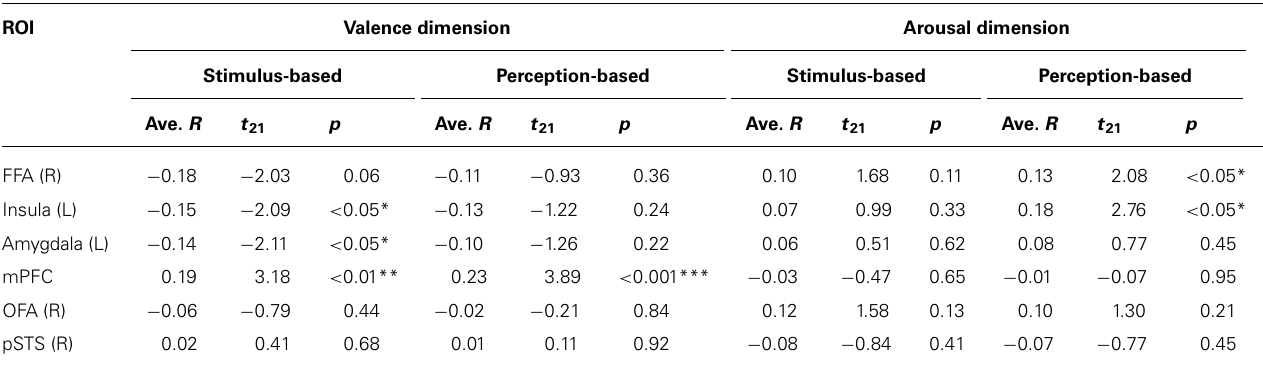
Table 3 |Analyses of dimensional (linear) processing in each ROI, after subject-wise validation. ROI Valence dimension Arousal dimension Stimulus-based Perception-based Stimulus-based